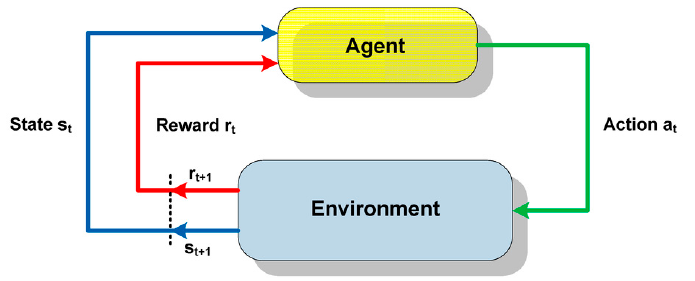
Figure 4. Basic idea and elements involved in a reinforcement learning formalization.